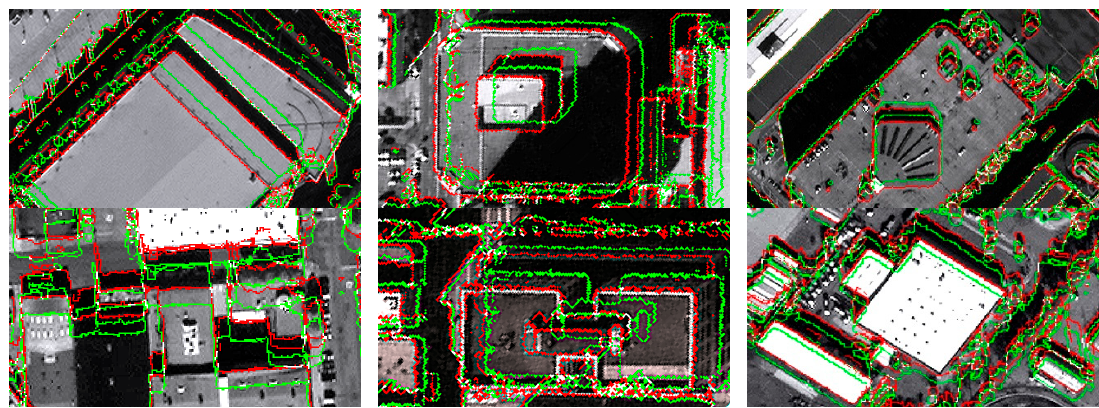
Figure 25. Some examples of the large differences between the coarse and fine 3D models.